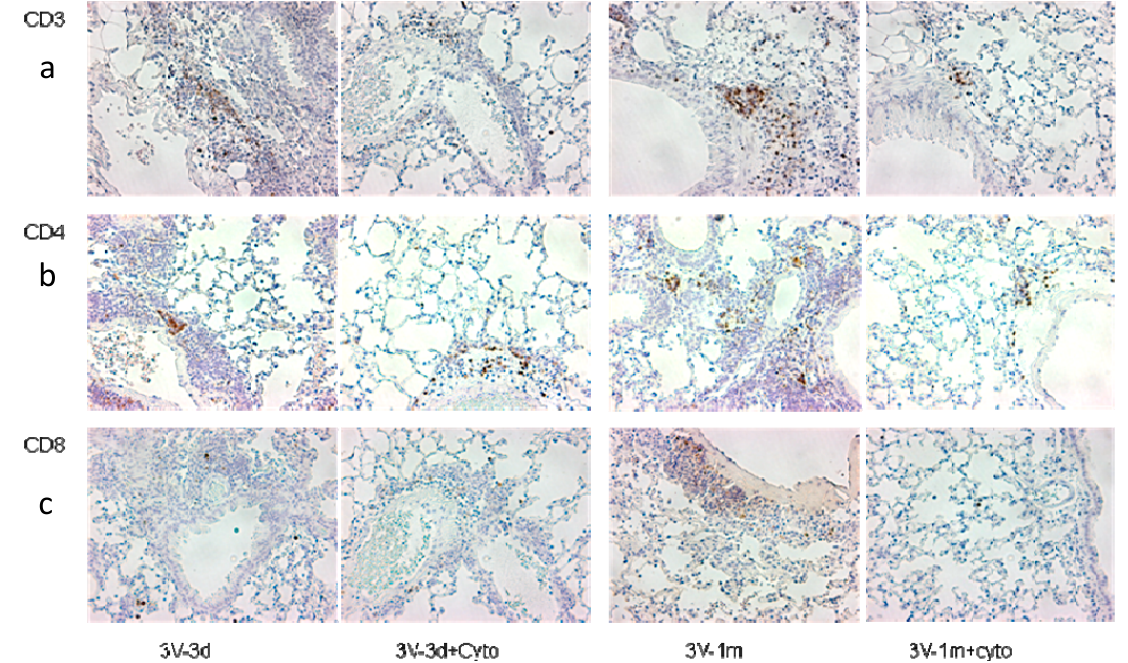
Figure 3. CD3 ( a ), CD4 ( b ), and CD8 ( c ) protein expression in mouse lungs. IHC (immunohistochemical) staining was performed in paraffin sections of mouse lungs and stained with antibodies against CD3, CD4, and CD8. The positive cells are shown in brown color. The sample labelling is the same as in Figure 2.